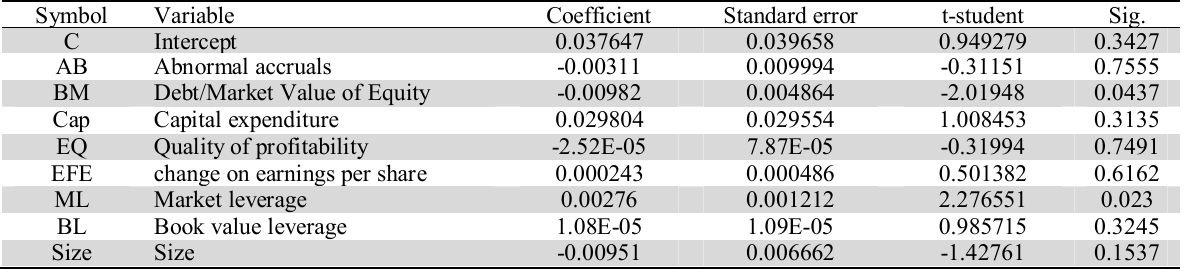
The summary of regression